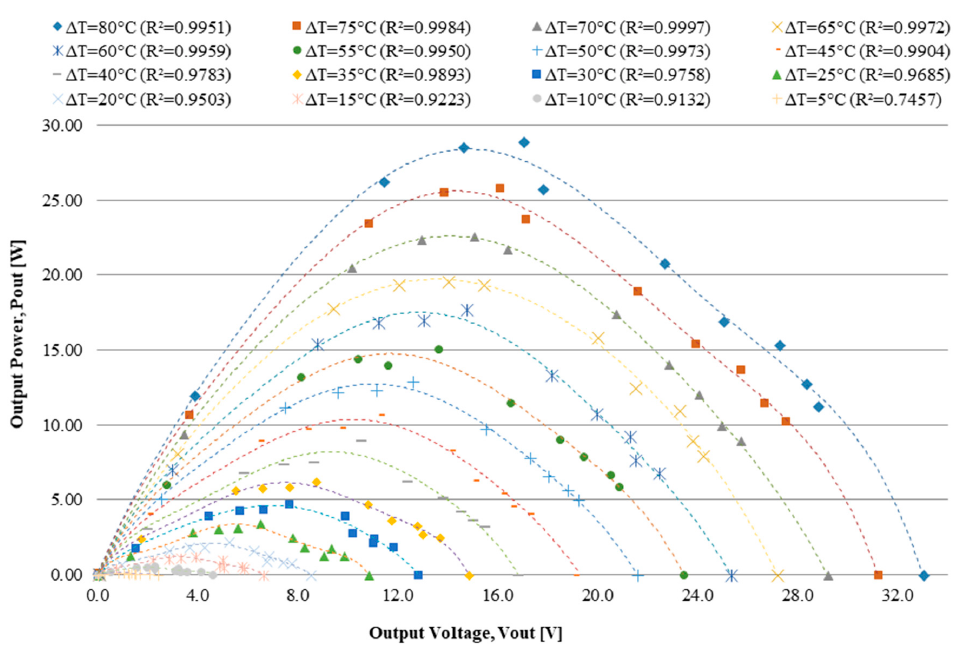
Figure 7. Output power–output voltage curve as function of temperature gradient.